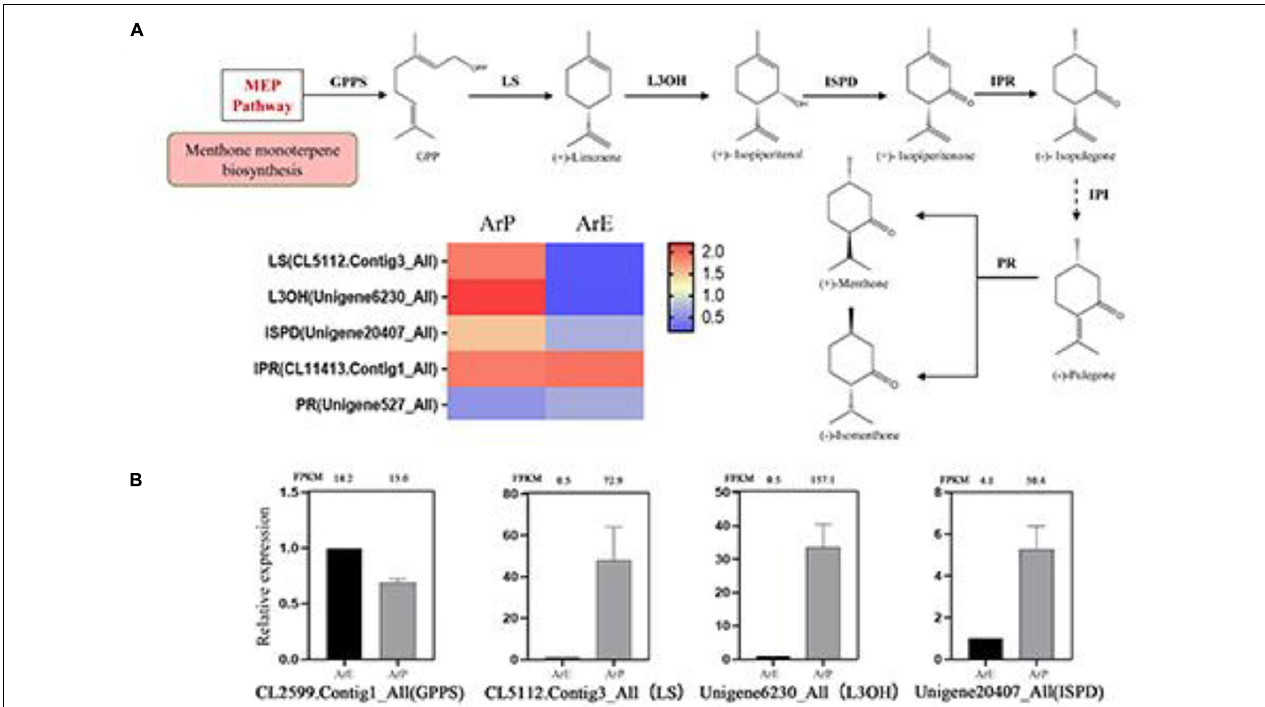
FIGURE 4 | Schematic overview of the monoterpenoid biosynthesis pathway and the expression of representative genes by RT-qPCR. (A) Schematic overview of the monoterpenoid pathway in A. rugosa and heatmap of the corresponding enzymes involved in the pathway. The main enzymes are shown with the abbreviation throughout respective enzymatic steps. Enzyme abbreviations are GPPS, geranyl diphosphate synthase; LS, limonene synthase; L3OH, limonene-3-hydroxylase; ISPD, isopiperitenol dehydrogenase; IPR, isopiperitenone reductase; IPI, isopiperitenone isomerase; PR, pulegone reductase. (B) The expression level of representative genes involved in menthol biosynthesis in A. rugosa